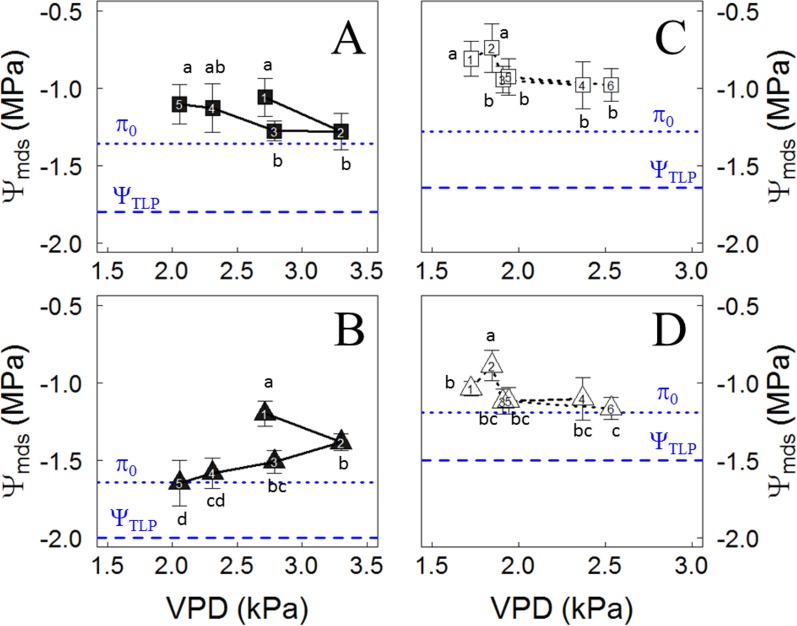
Midday water potential (Ψmds) responses to vapor pressure deficit (VPD) in Carménère (squares) and Syrah (triangles) grapevines without irrigation in the Cachapoal (A and B) and Maipo (C and D). The number inside each symbol represent the week of drought progression. The blue segmented line corresponds to the values of osmotic potential at full turgor (π0) and the water potential at the turgor loss point (ΨTLP), shown in
Table 3
. Different letters indicate statistically significant differences between weeks of drought for the varieties in each site. Mean ± SD are presented.